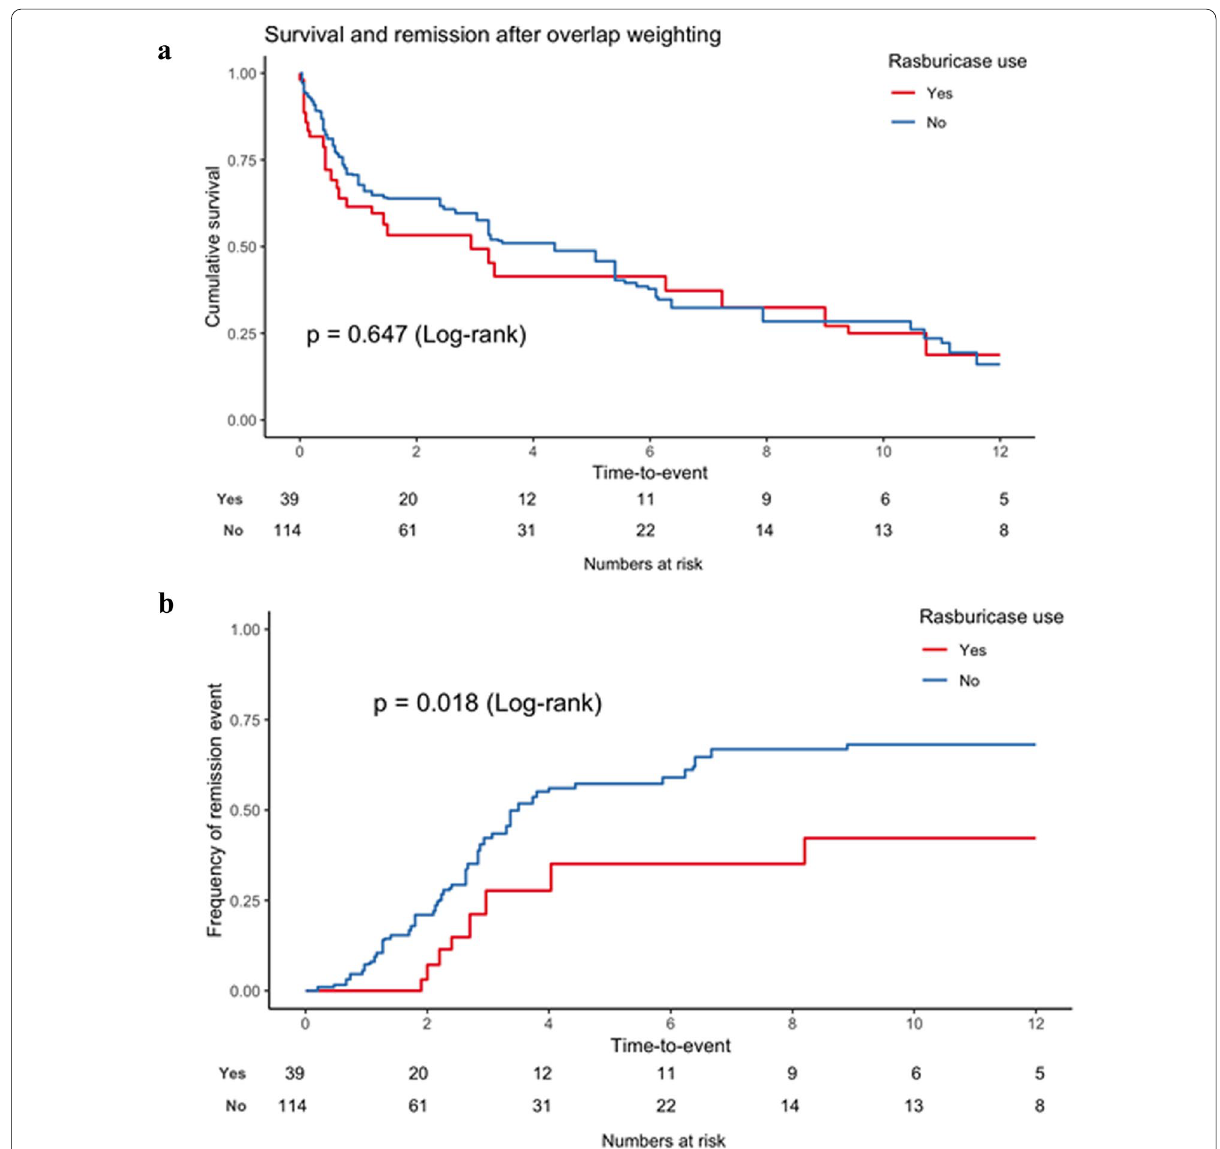
Fig. 4 Outcome according to use of rasburicase after propensity score weighting. a Kaplan–Meier survival estimates according to rasburicase use. b Cumulative incidence of remission according to rasburicase